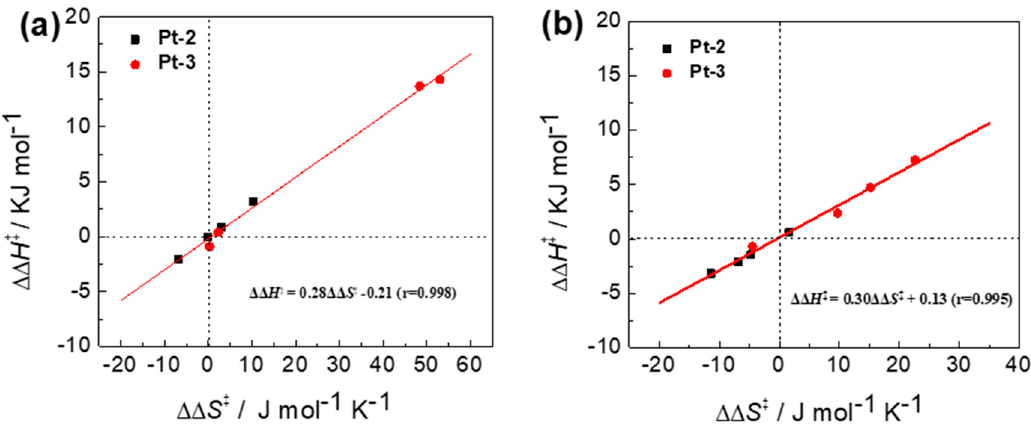
Figure 4. Enthalpy–entropy compensation plot for the differential parameters of the enantiomers of 2 obtained in the photocyclodimerization of AC catalyzed by Pt-2 ( ■ ) and Pt-3 ( ● ). ( a ) of the ee of 2, ( b ) of the ee of 3 .